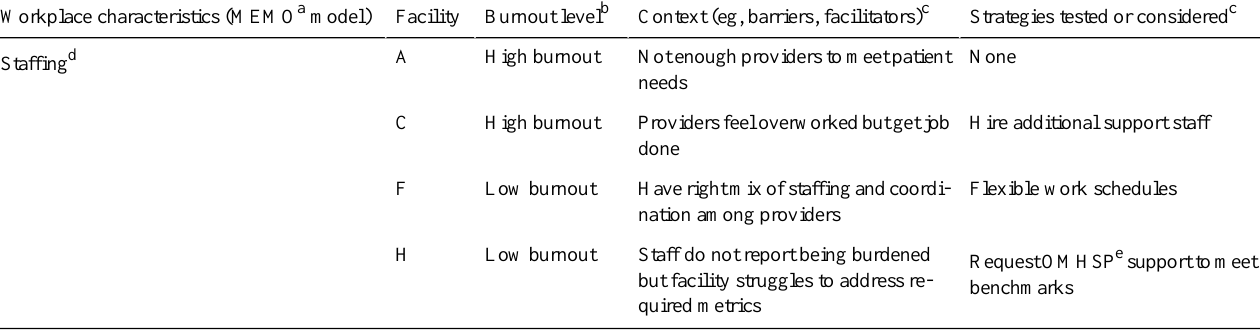
Table 2. Sample joint